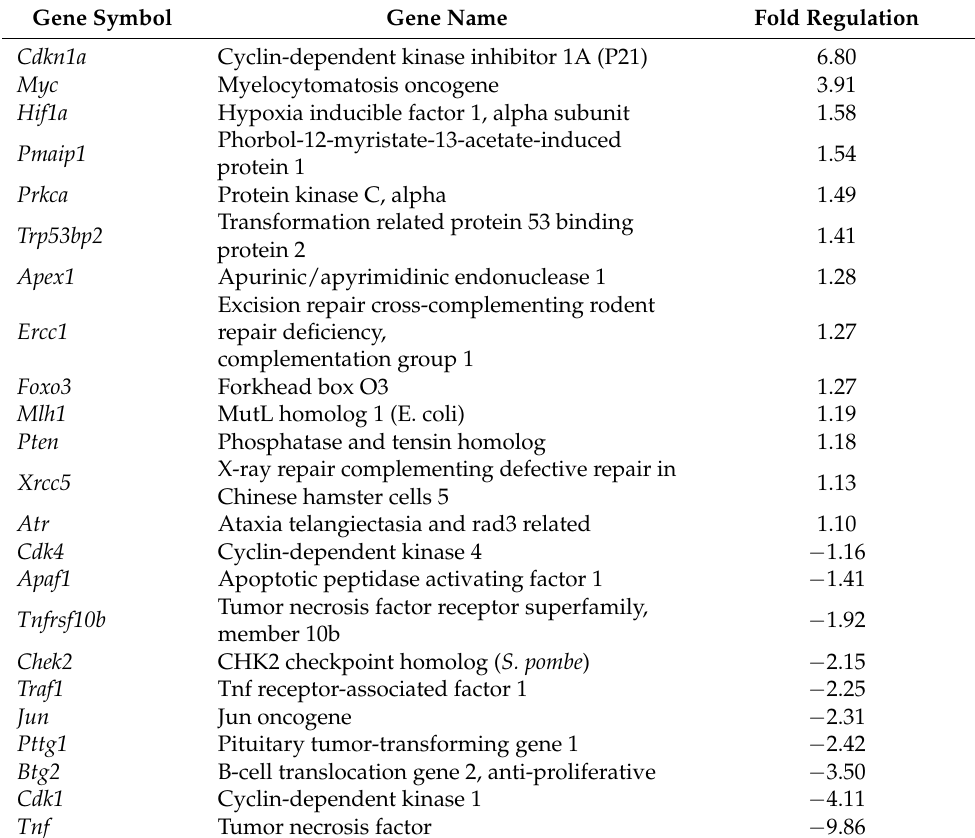
Table 2. Spaceflight altered the expression of genes involved in the Trp53 signaling pathway. Ex- pression levels are represented as fold regulation in spaceflight versus ground controls (FLT versus GRD). Shown are 23 differentially regulated genes out of a panel of 84 genes related to the Trp53 signaling pathways as assessed by RT-PCR. Out of these, 13 genes were upregulated and 10 genes were downregulated. The change in expression levels of these genes were found to be statistically significant by Mann–Whitney U test at p < 0.05, n =